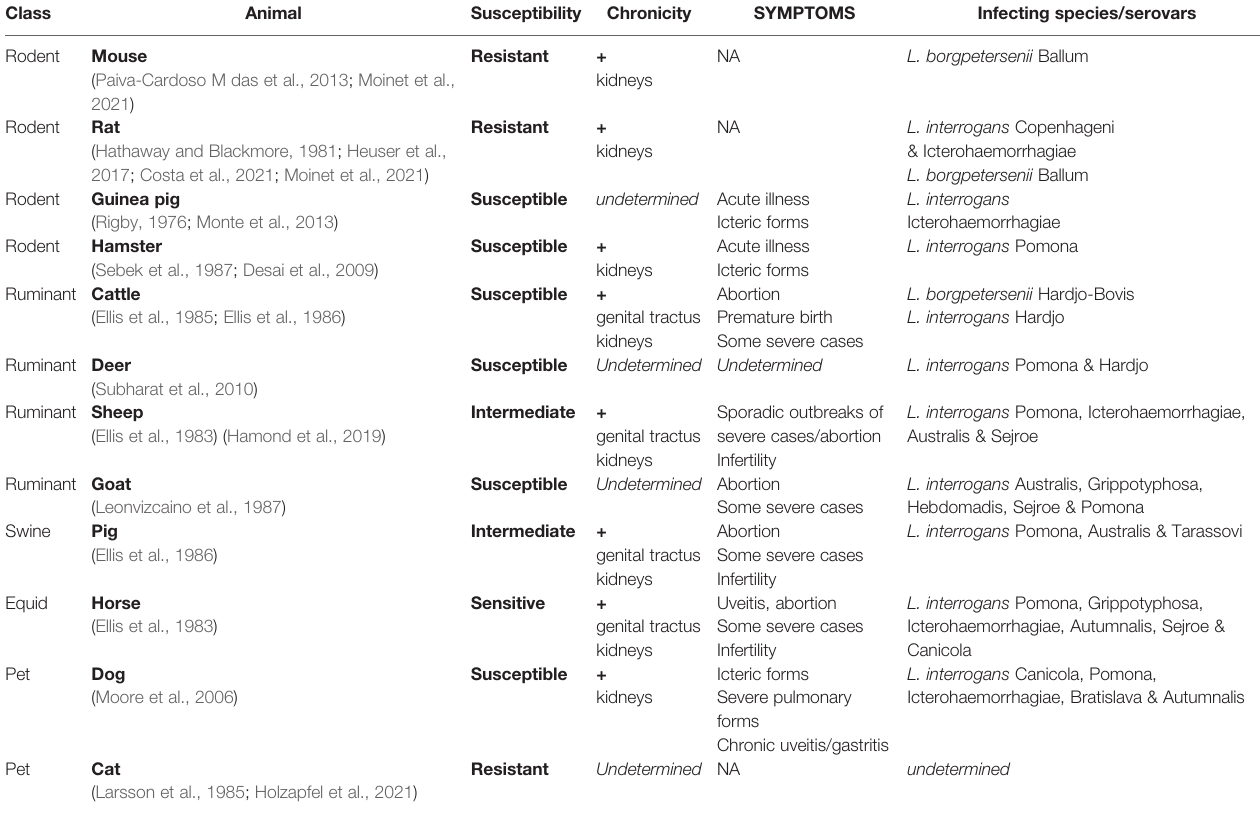
TABLE 1 | Susceptibility and symptoms of various animal hosts upon natural infection by Leptospira spp.